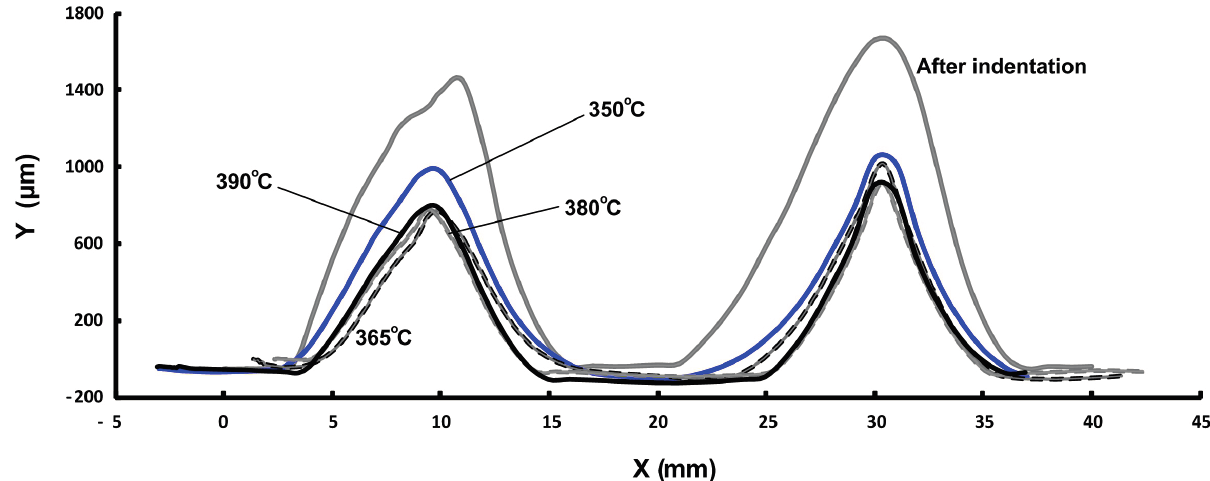
Figure 3. The heating-responsive SME in Polyimide (PI) tape (comparison of cross-sections of two indents right after indentation and in subsequent step-by-step heating to different